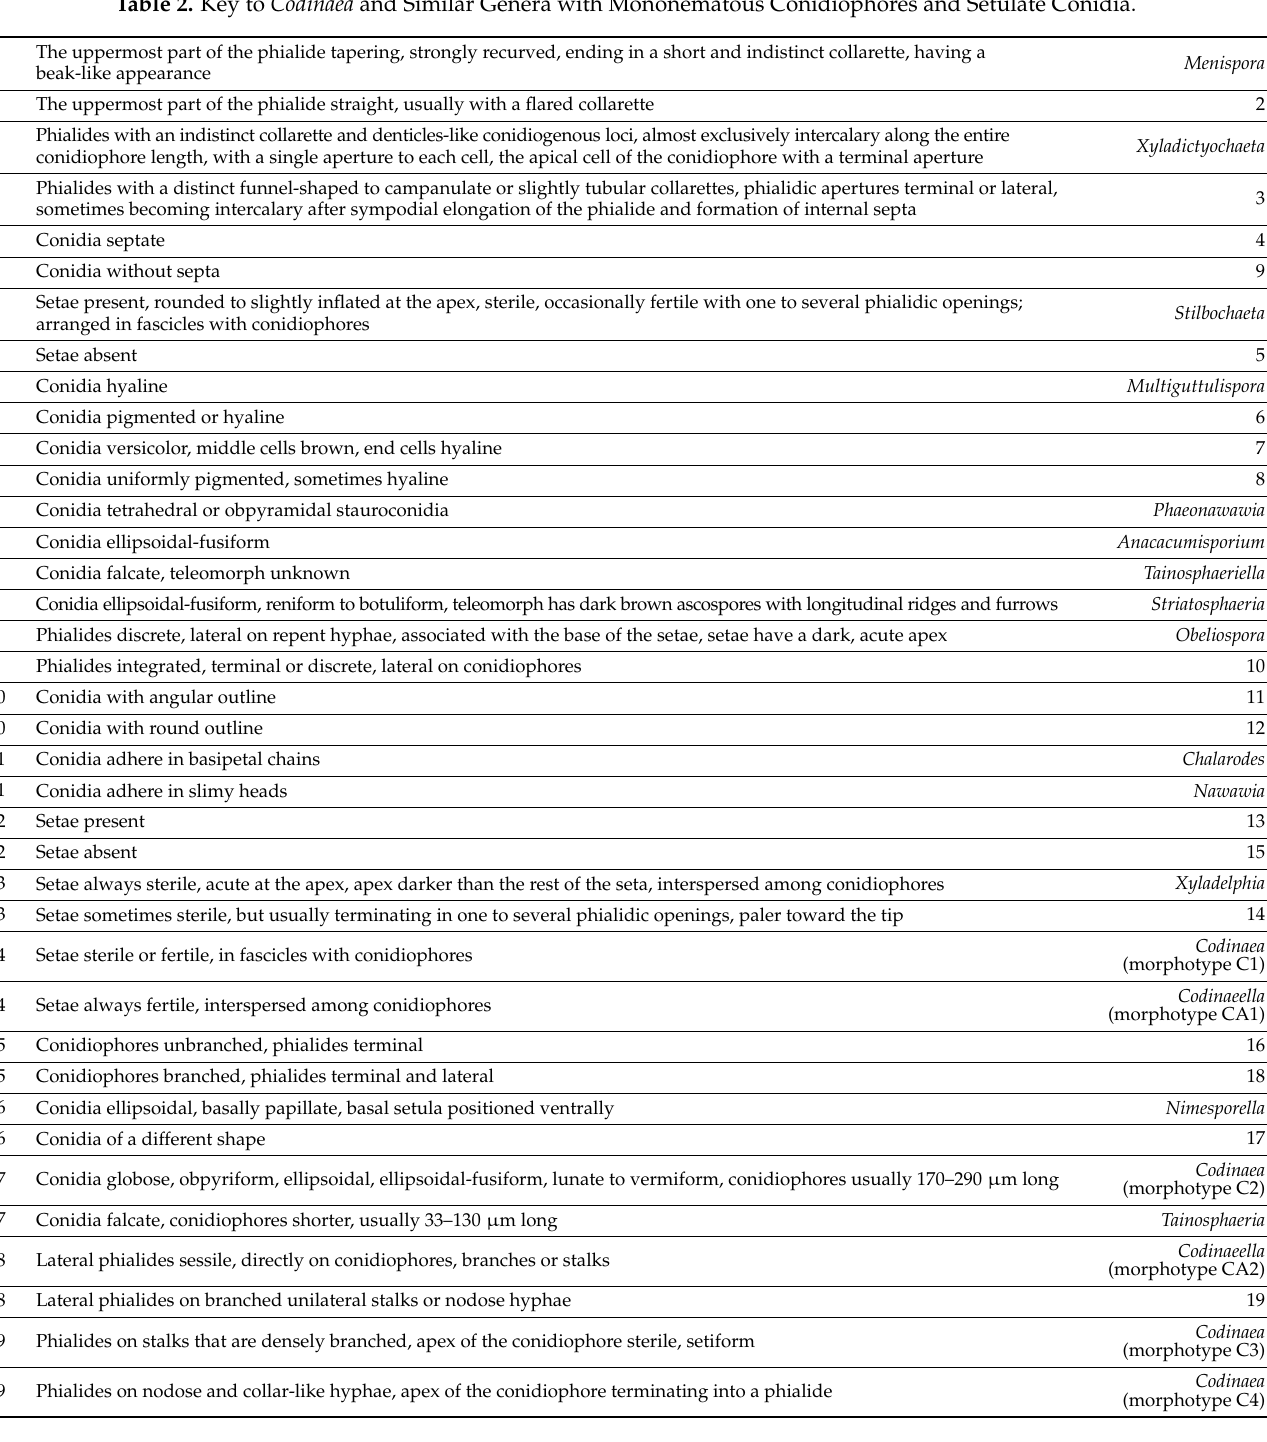
Table 2. Key to Codinaea and Similar Genera with Mononematous Conidiophores and Setulate